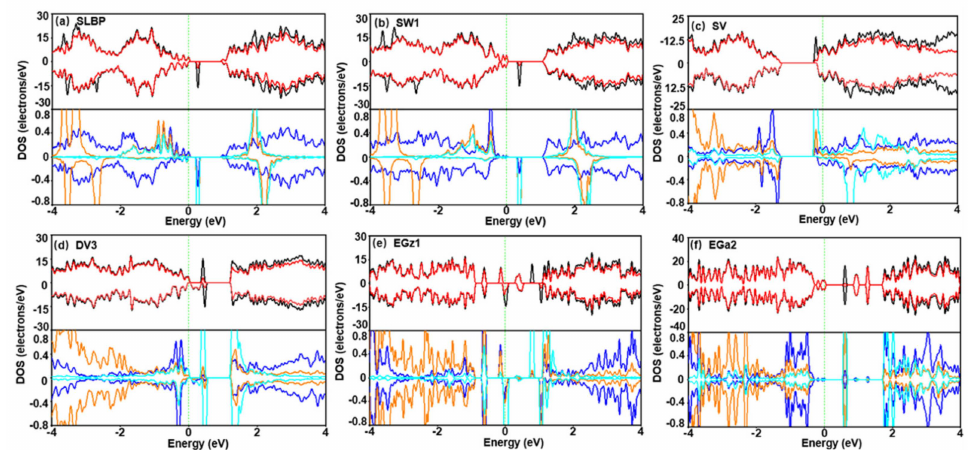
Figure 5. TDOS of adsorption complexes of NO 2 and SLBP/d − SLBP (black solid line), and PDOS of SLBP/d − SLBP (red solid line) in adsorption complexes ( upper panel). ( a ) SLBP, ( b ) SW1, ( c ) SV, ( d ) DV3, ( e ) EGz1 and ( f ) EGa2. Partial DOS of p orbitals of N (cyan solid line) and O (orange solid line) atoms, and P atom (blue solid line) ( lower panel). Green dash line: Fermi